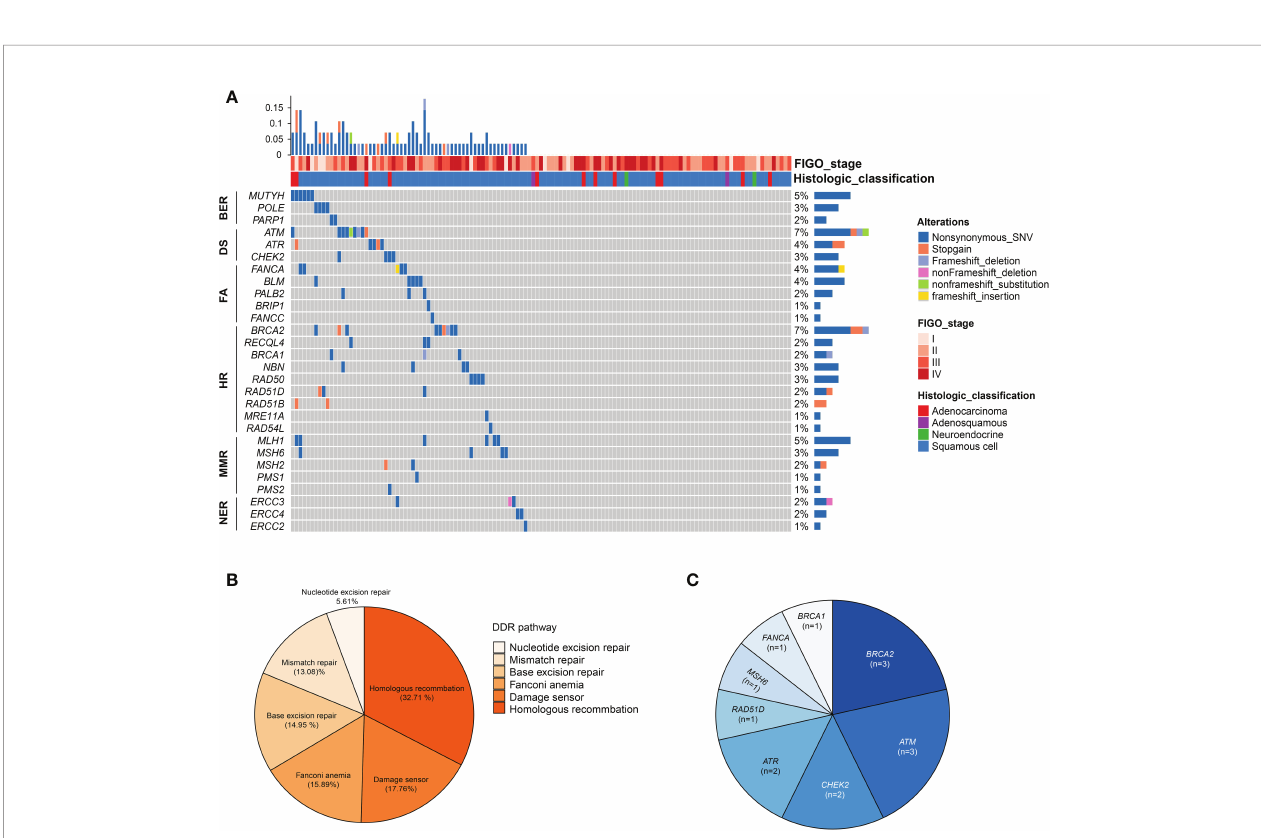
FIGURE 3 | Alterations in DNA damage repair (DDR) pathway. (A) Oncoprint of the DDR alterations in 129 cervical cancer patients. (B) Frequency of altered pathway of DDR. (C) The distribution of known or likely deleterious DDR alterations. HR, homologous recombination; FA, fanconi anemia; MMR, mismatch repair; NER, nucleotide excision repair; BER, base excision repair; DS, DNA sensor.